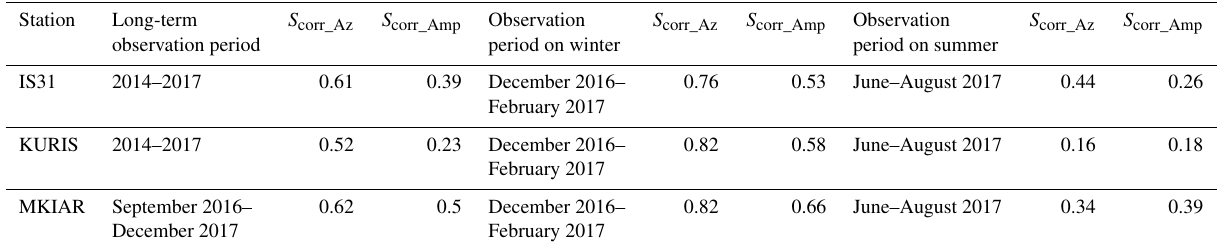
Figure 4. Dominant amplitude of microseisms in the 0.1–0.4Hz band detected at ABKAR (a) , KKAR (b) , Kurchatov Cross (c) , and MKAR (d) arrays from 1 December 2016 to 31 January 2017. Table 2. Estimations of the prediction quality for microbarom amplitudes and